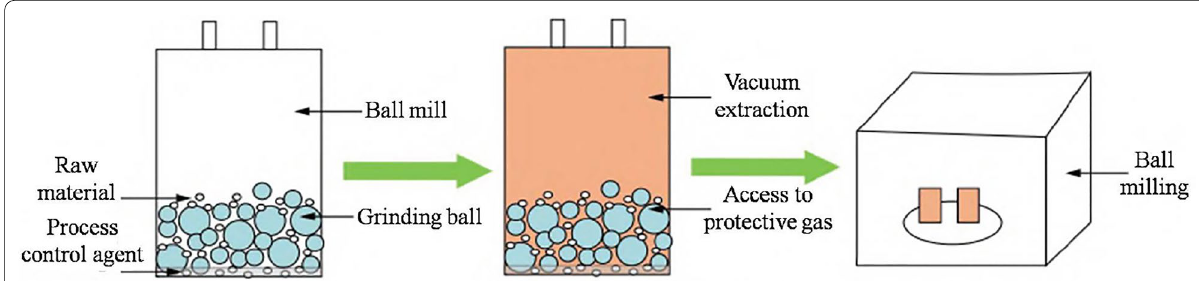
Figure 11 Schematic diagram of high entropy alloy prepared by mechanical alloying [52]